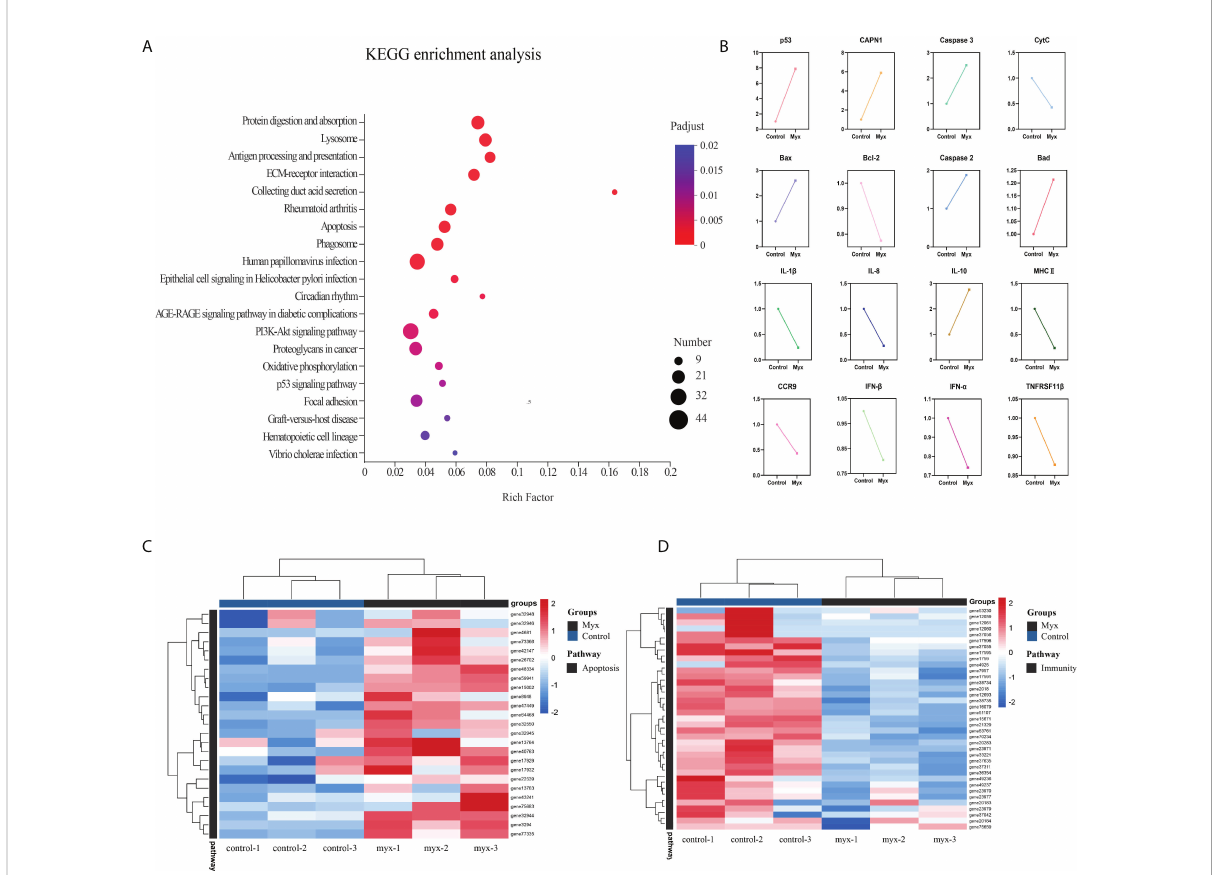
FIGURE 6 Enrichment analysis and cluster analysis of gold fi sh gill tissue transcriptome. (A) Scatter plots of enriched gene ontology biological process (BP) terms for gill tissue in two groups using the KEGG database. The fold enrichment indicates the ratio of the expressed gene number to the total gene number in a pathway. Only the top 20 BPs according to p-value were shown. The size and color of the points represent the gene number and the log10 p-value of each pathway, respectively. (B) Expression patterns of DEGs associated with apoptosis and immunity in the KEGG enriched pathway. (C) Heatmap of apoptosis-related DEGs. (D) Heatmap of immune-related DEGs. Red and blue indicated the up regulated and down-regulated gene, respectively. The scale of the color bar represented fold changes of gene expression. Myx 1 – 3 represent gill tissue samples with Myxobolus ampullicapsulatus infection. Control 1 – 3 represent gill tissue from healthy fi sh without parasite